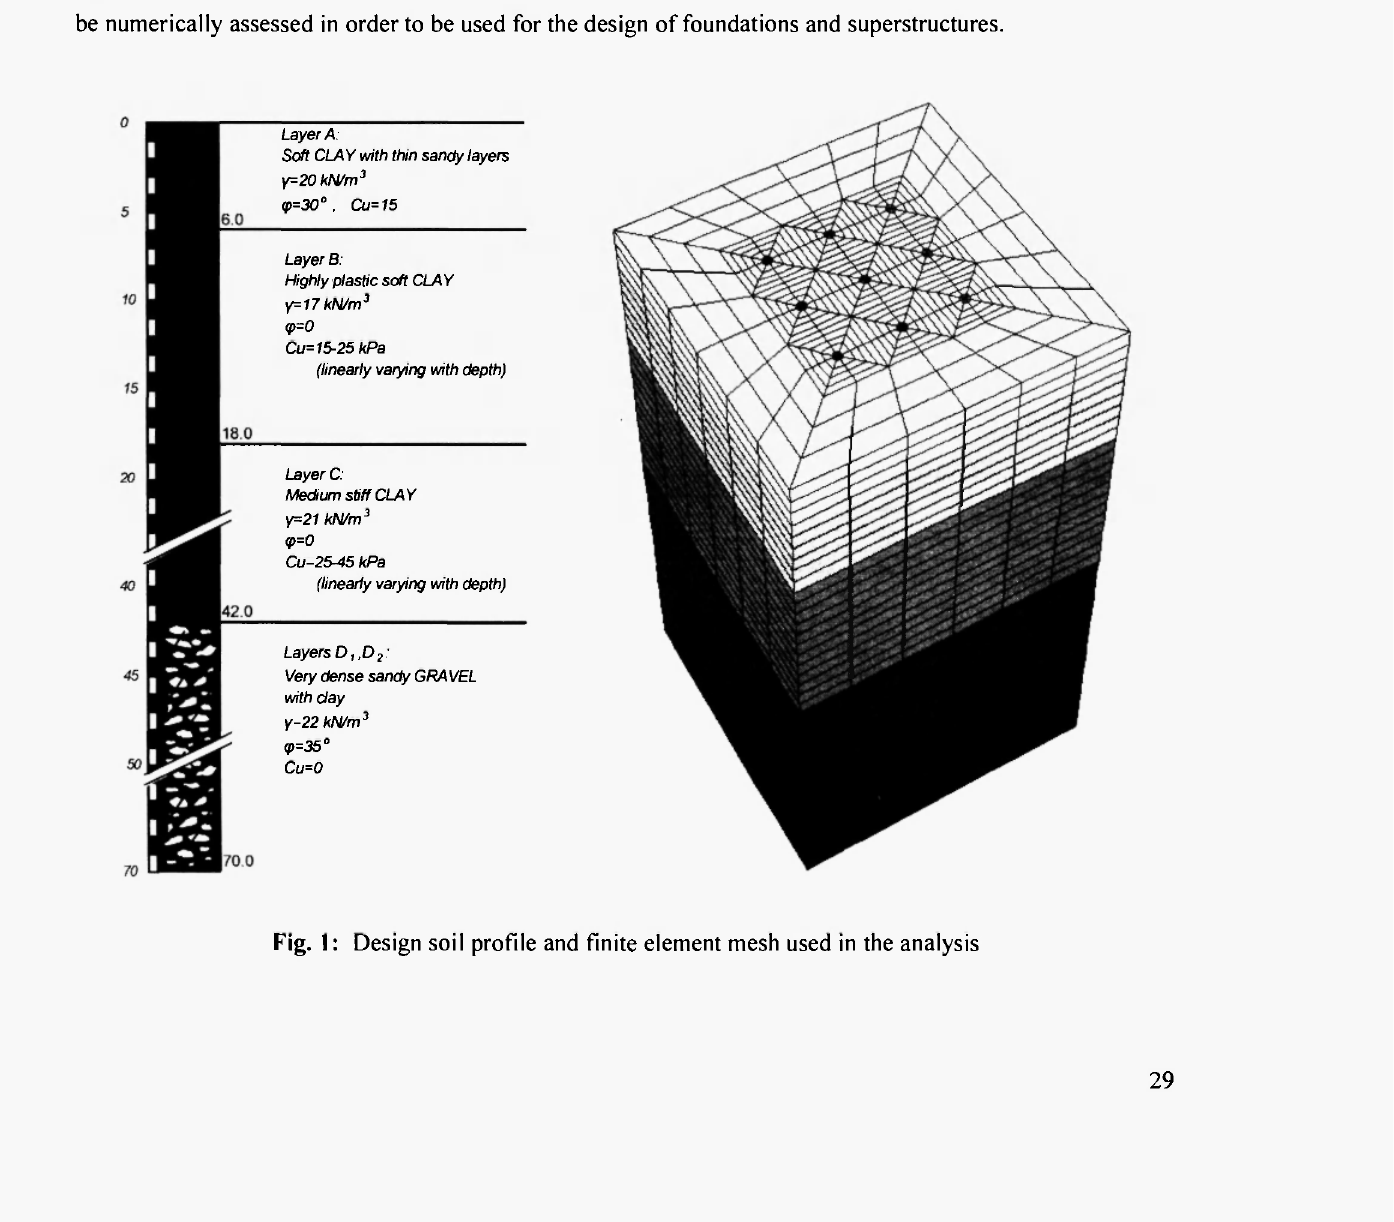
Fig. 1 : Design soil profile and finite element mesh used in the